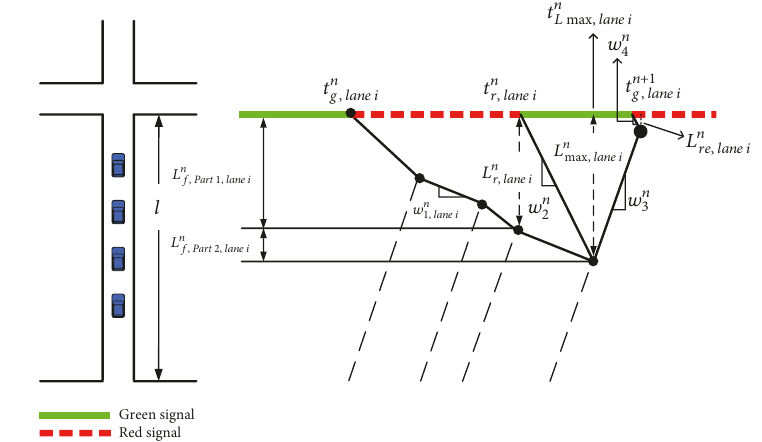
Figure 3: Two parts of queue length forming process.